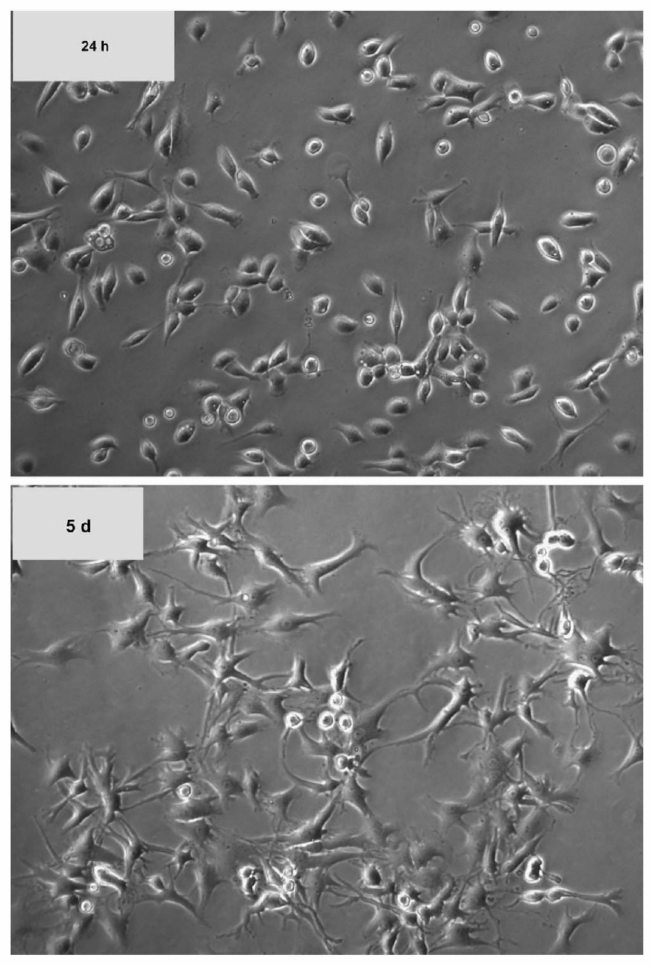
Figure 1. Morphological changes of chondrocytes with time in culture. The chondrocytes become dedifferentiated during in vitro expansion and the morphology gradually changes from rounded and cobblestone to elongated and slender. (reproduced from reference